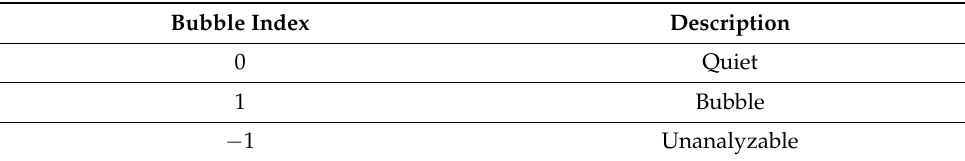
Table 1. The Bubble index